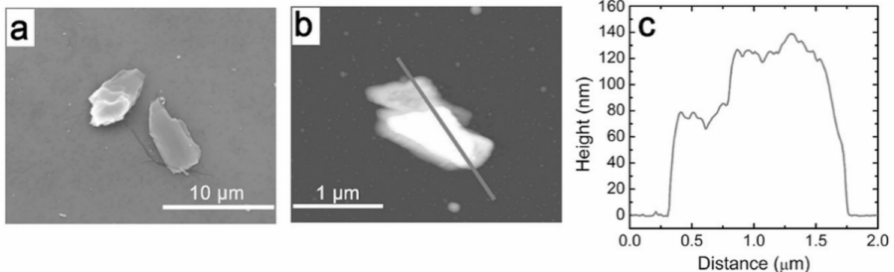
Figure 5. ( a ) Scanning electron microscope image and ( b ) atomic force microscopy image of the prepared WTe 2 microflakes on a glass substrate. ( c ) The height profile measured along the red line in ( b ). Reprinted with permission from [33].